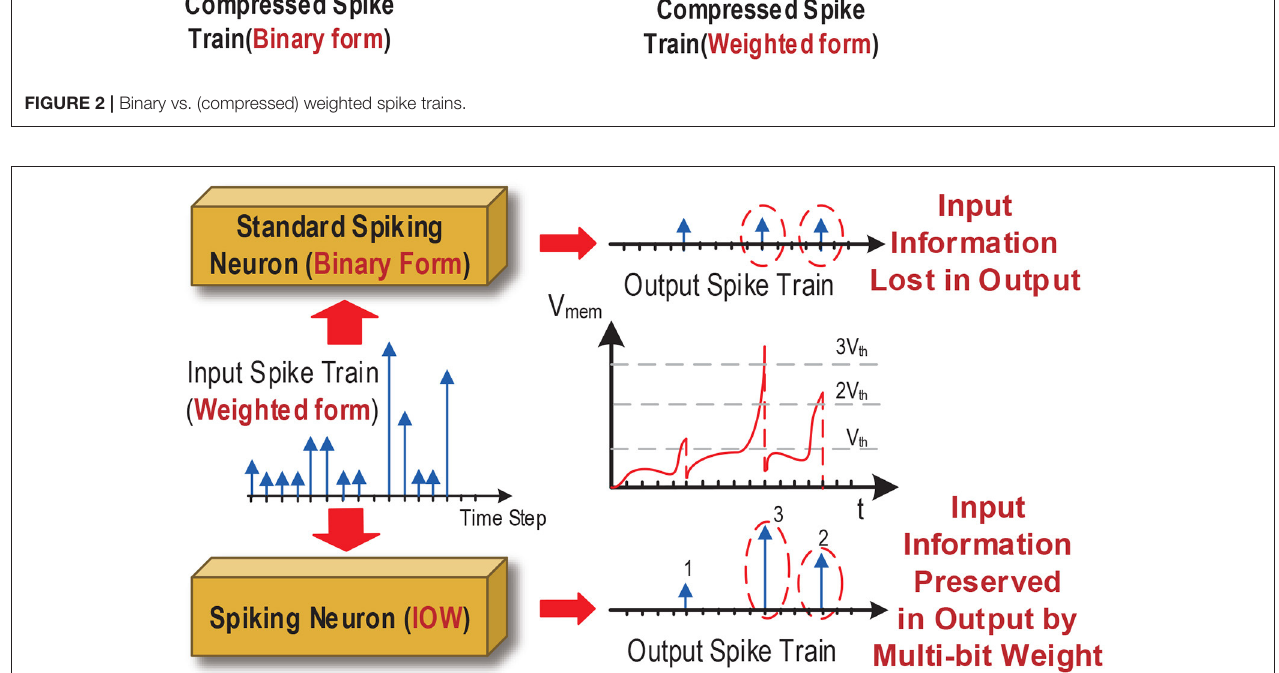
FIGURE 3 | Binary vs. weighted output